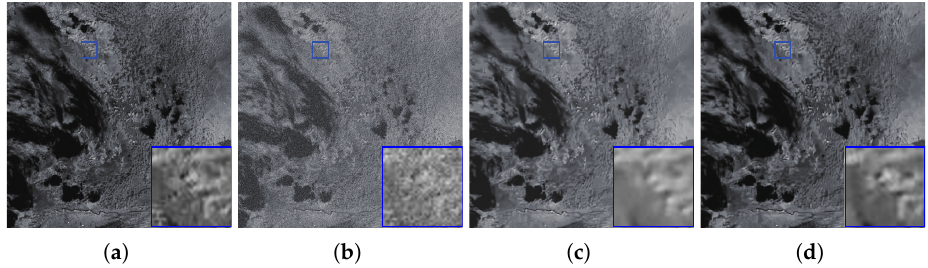
Figure 1. An example of a visual comparison between the model-based method (WSSR) (PSNR | SSIM: 27.2 dB | 0.7155) and the proposed MD 3 approach (PSNR | SSIM: 27.63 dB | 0.7352) on the MODIS-A1 image with size 512 × 512 and noise level σ = 25. ( a ) Ground-truth. ( b ) Noised. ( c ) WSSR [6]. ( d )